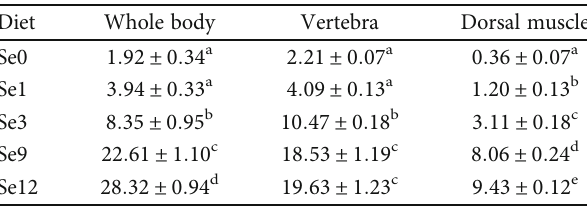
Data are presented as mean ± SD ( n = 3 ). The data with di ff